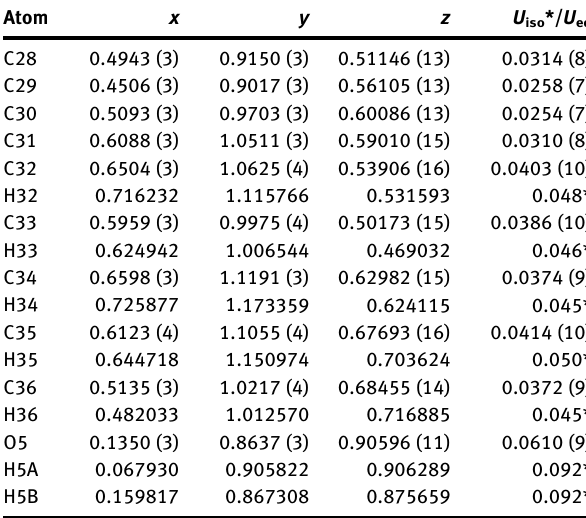
Table  : Fractional atomic coordinates and isotropic or equivalent isotropic displacement parameters (Å 